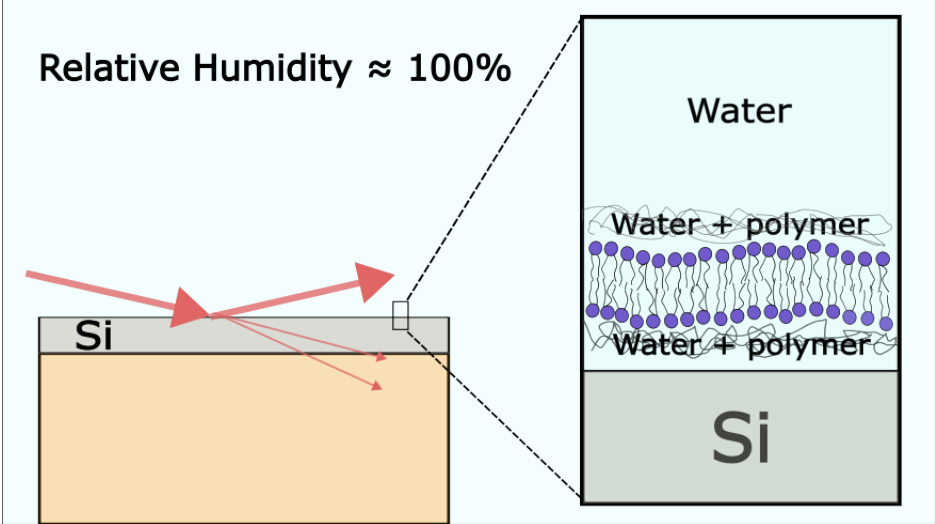
Figure 9. Schematic drawing of grazing-incidence X-ray diffraction measurements of a highly hy- drated polymer-cushioned SLB. The figure is based on an image from ref. [78]. hydrated polymer-cushioned SLB. The figure is based on an image from ref.